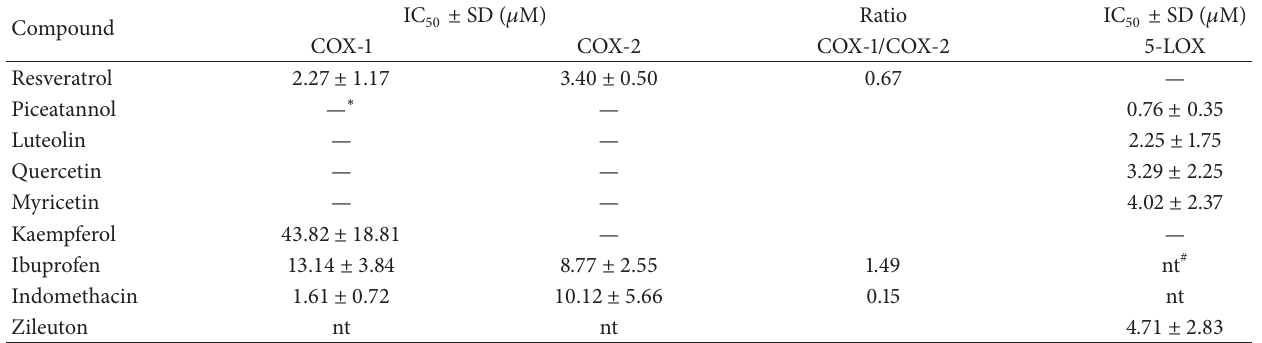
Table 3: IC values of wine constituents and reference inhibitors for COX-1, COX-2, and 5-LOX. 50 Compound